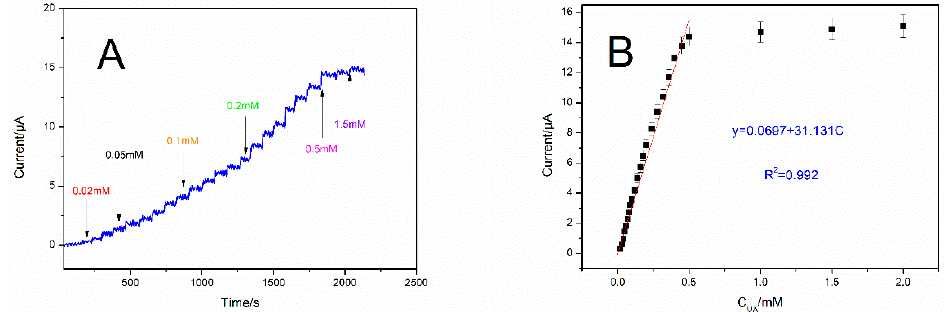
Figure 4. ( A ) Amperometric response after continuous progressive addition of uric acid (UA) with UOx/BSA/BLG-MWCNTs-PtNPs/GCE in 0.1 M PBS solution under stirring; ( B ) the calibration